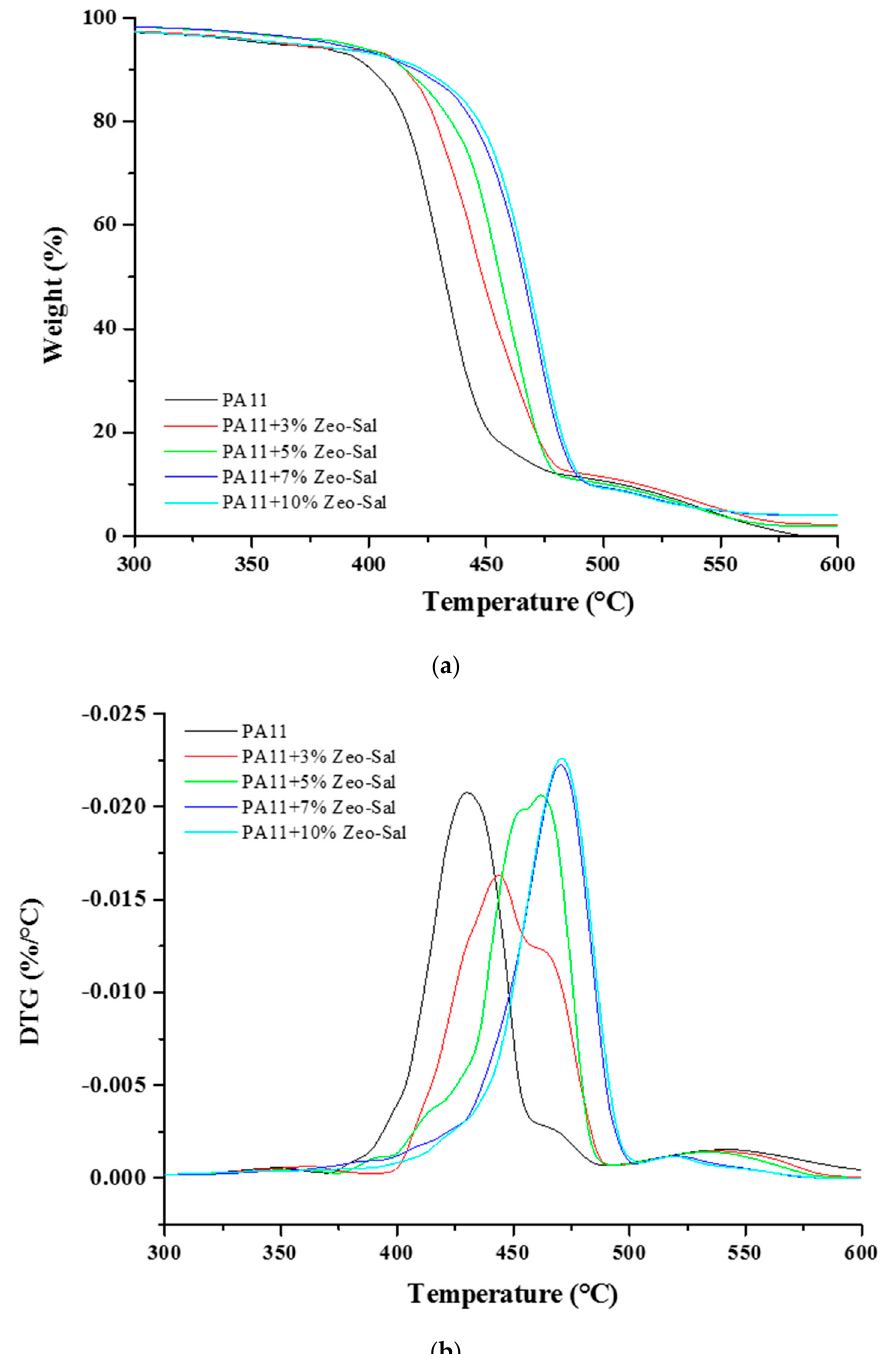
Figure 5. Thermogravimetric analysis on PA11 and composite materials (PA11 + Zeo-Sal). ( a ) TGA curves; ( b ) DTG curves.